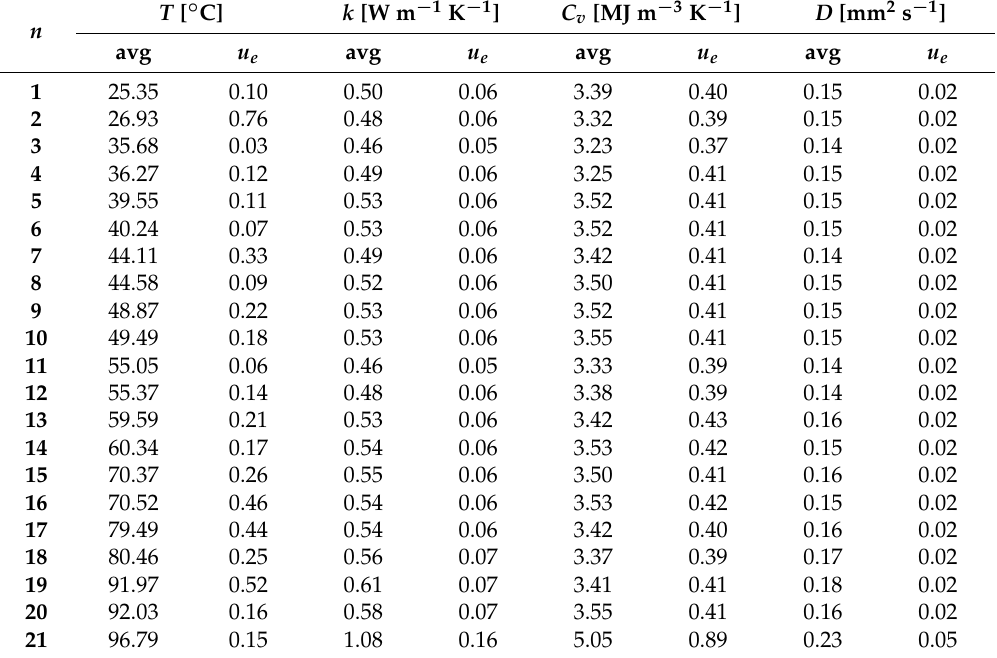
Table 1. Thermal properties (i.e., thermal conductivity, k , volumetric heat capacity, C v , and thermal diffusivity, D ) for each ex vivo ovine liver sample ( n ) at different increasing temperatures (average values, avg). The associated uncertainty of each thermal property is given by u e